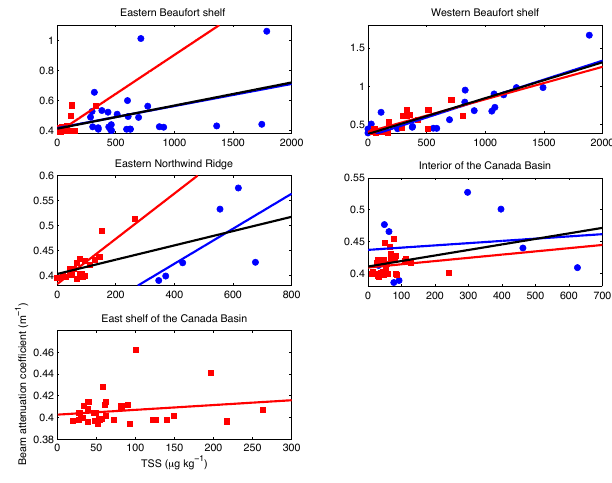
Fig. 15. Linear regression of the relationship between beam atten- uation coefficient and total suspended solids (µgkg − 1 ) in the five different regions. Here, the blue circles are samples from 2006 and the red squares are from 2007. The lines denote the linear least square regression from 2006 (blue lines), 2007 (red lines) and both 2006 and 2007 (black lines). Linear relations and R 2 values are listed in Table 1. Note that the scales are different in each